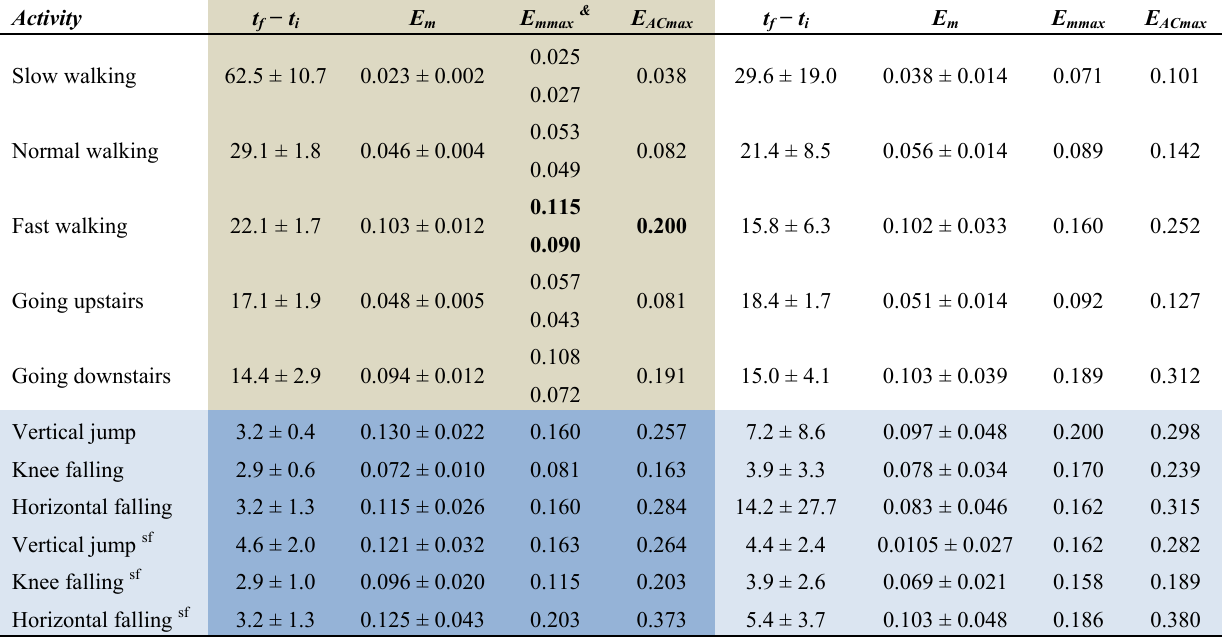
Table 1. Main results of the energy study. Values are presented as mean ± SD for all sets in each laboratory study: personalized (8 sets, left); and non-personalized (12 sets,